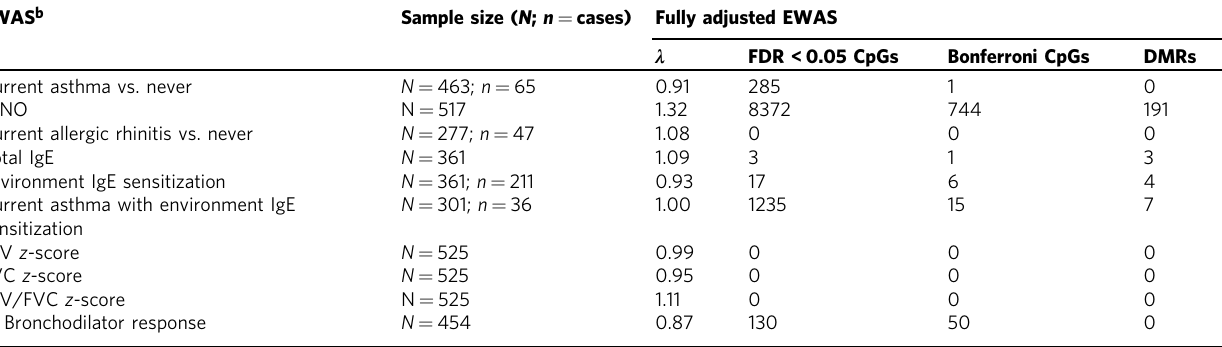
λ genomic in fl ation factor, EWAS epigenome-wide association analyses, FeNO fractional exhaled nitric oxide, FDR false discovery rate, DMRs differentially methylated regions with ≥ 5 CpGs with a Stouffer FDR P <0.05, IgE immunoglobulin E, FEV forced expiratory volume, FVC forced vital capacity, PCs principal components a Number of differentially methylated CpGs (FDR <0.05 and Bonferroni correction) and DMRs ( ≥ 5-CpGs and FDR <0.05) b Analyses adjusted for child race/ethnicity, sex, age at sample collection, BMI z -score, maternal education, smokers living in the house, sine and cosine of season at sample collection, and cellular heterogeneity (10 PCs from ReFACToR)